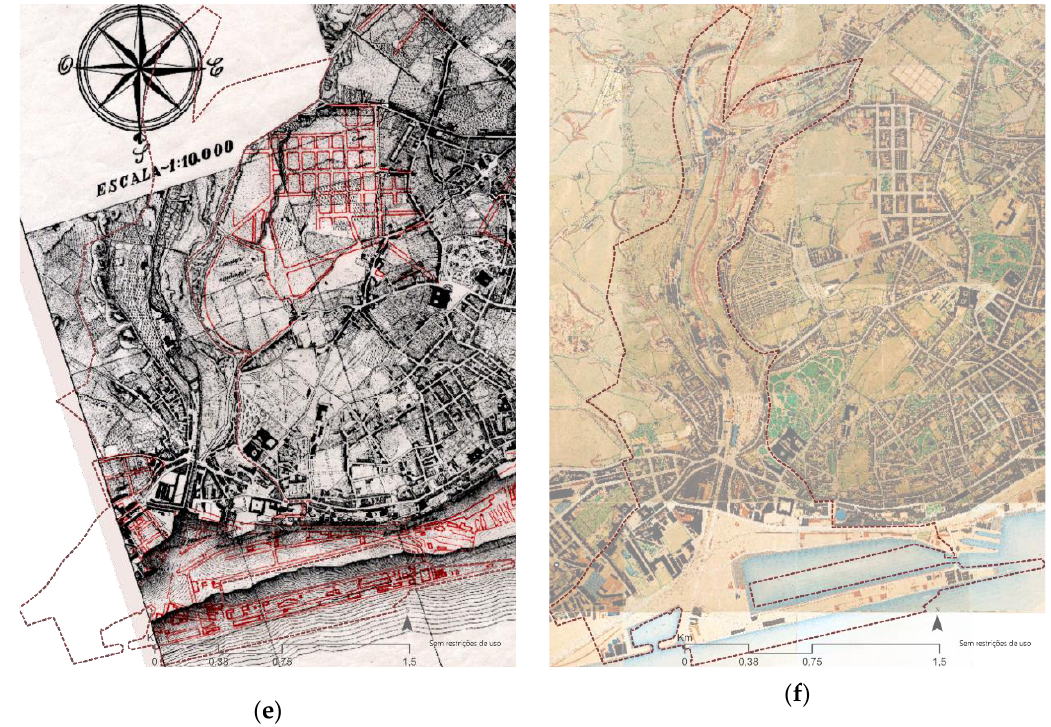
Figure 2. Historical Cartography of Lisbon (excerpt superimposed by the active Urban Development Plan (dashed line, dark red) for Alcântara. Sources: Own production over CML open-source databases (see Backmatter) ( a ) Duarte Fava Lisbon Map — 1807. ( b ) Lisbon Map — 1855. ( c ) Filipe Folque Lisbon Map — 1855 – 56( d ) Francisco & Cesar Goullard Lisbon Map — 1878. ( e ) Lisbon Map — 1855 [superimposition in red with the Ressano Garcia Plans; Vieira da Silva collection]. ( f ) Silva Pinto Lisbon Map — 1904 – 11.